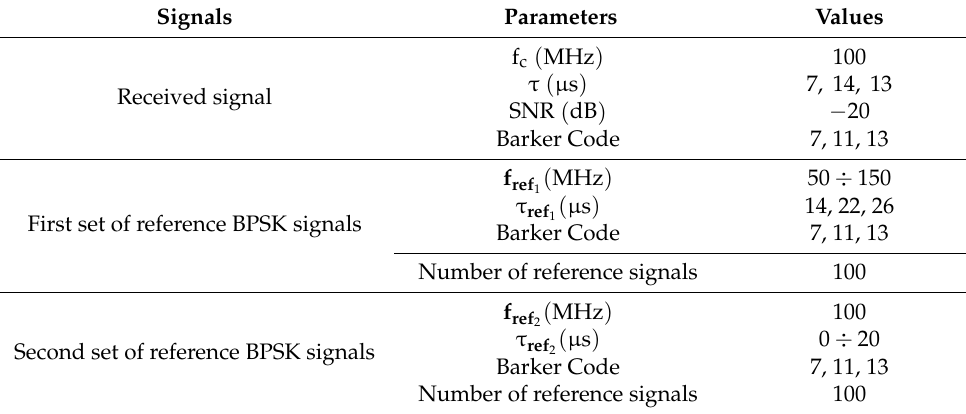
Table 2. Parameters of the simulated